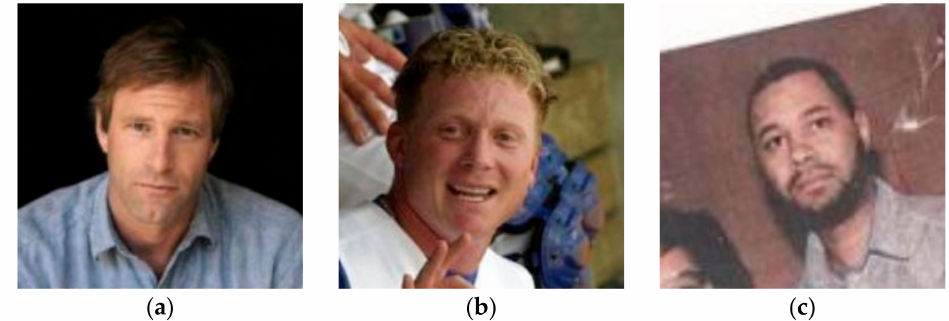
Figure 4. Image results using Labelled Faces in the Wild Home (LFW) database, ( a ) image-1, ( b ) image- 2, ( c ) image-3.